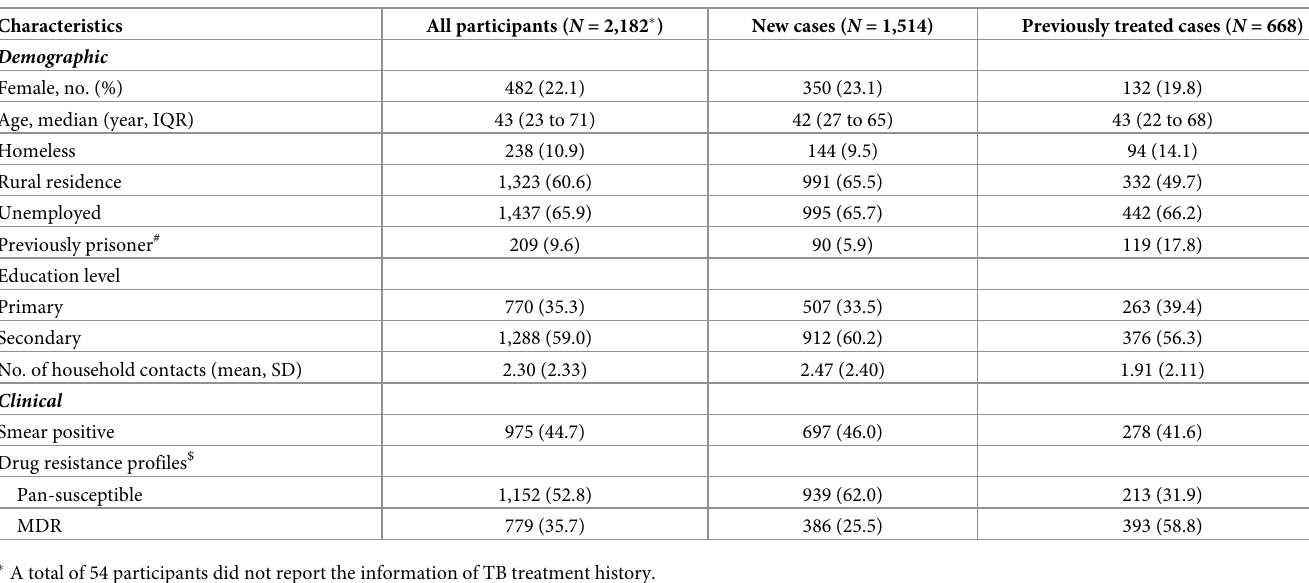
Table 1. Demographic and clinical characteristics of study